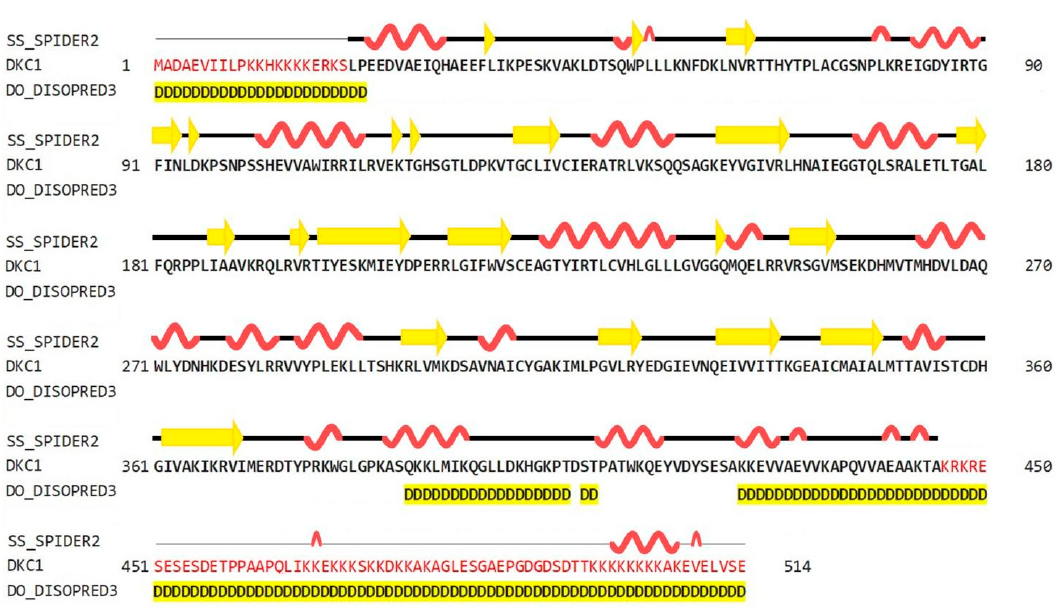
Figure 2. Secondary structure prediction of hDKC1 using HHPred (SPIDER2 (Scoring Protein Interaction Decoys using Exposed Residues) for secondary structure prediction, and DISOPRED (Disorder Prediction Server) for unstructured or disordered region predictions). Yellow arrows represent beta sheets; alpha helixes are shown in red; disordered regions are highlighted in yellow.